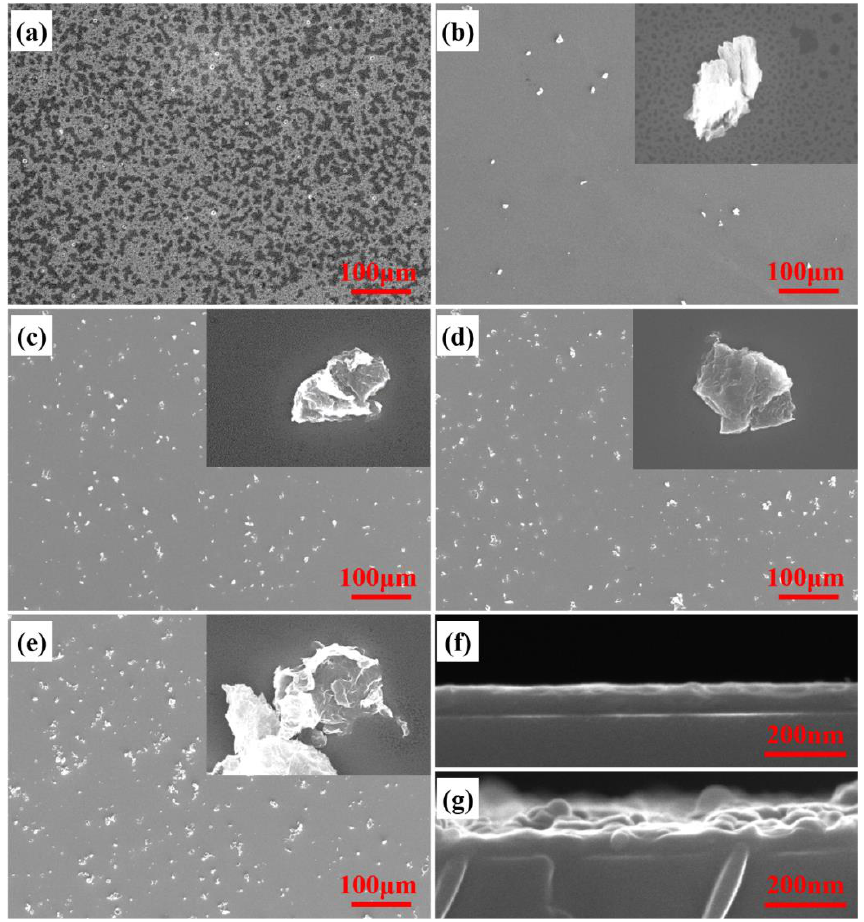
Figure 8. SEM images for front surface of ( a ) DA/Si, ( b ) DA@G1/Si, ( c ) DA@G2/Si, ( d ) DA@G3/Si, and ( e ) DA@G1/Si and the inserts were the images with high magnification. SEM images for cross-section of ( f ) PEDOT:PSS/Si and ( g ) PEDOT:PSS/DA@G3/Si.